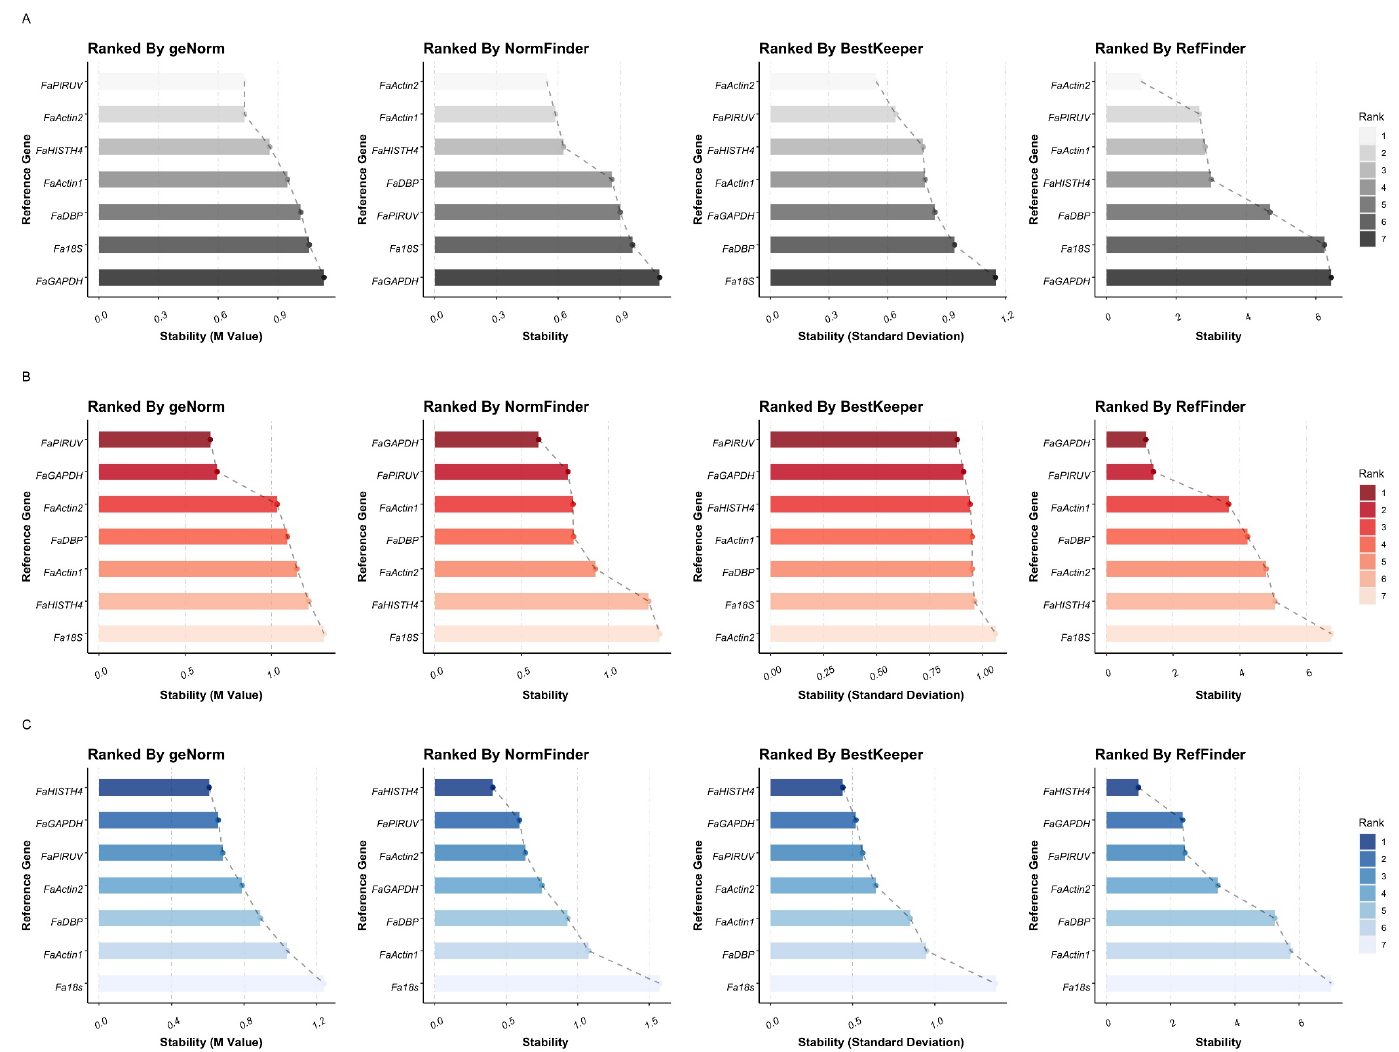
Figure 4. Expression stability ranks of the candidate reference genes under different types of light: white-light treatment ( A ), red-light treatment ( B ), and blue-light treatment ( C